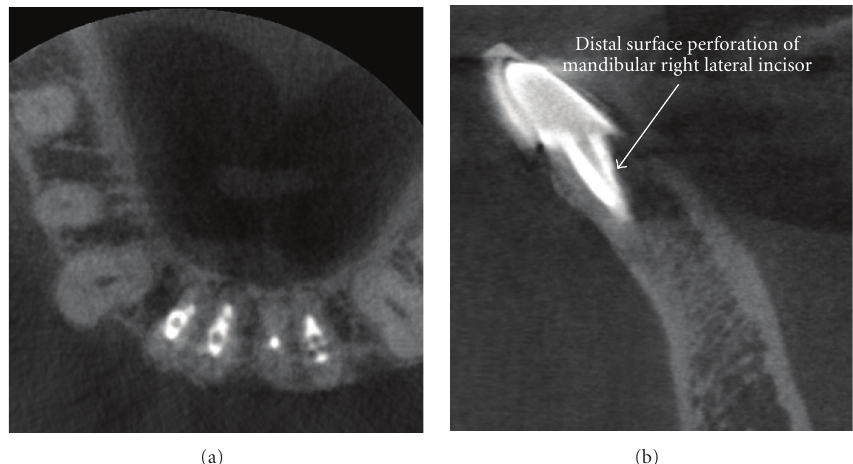
Figure 17: Iatrogenic perforative defects can be di ffi cult to confirm by periapical radiography alone. This patient was referred for evaluation and possible endodontic revision of the mandibular right lateral incisor because of chronic sensitivity to occlusal forces. CBCT images ((a) axial, (b) sagittal) demonstrate a mid-root post